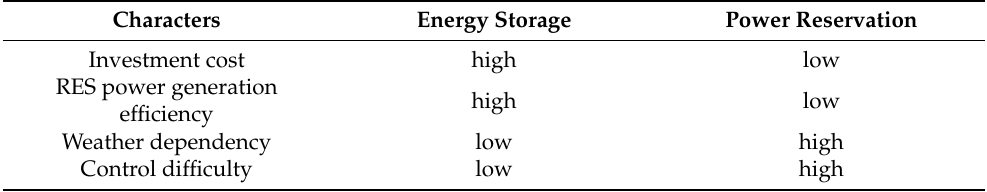
Table 4. The comparison of power reserve and energy storage.